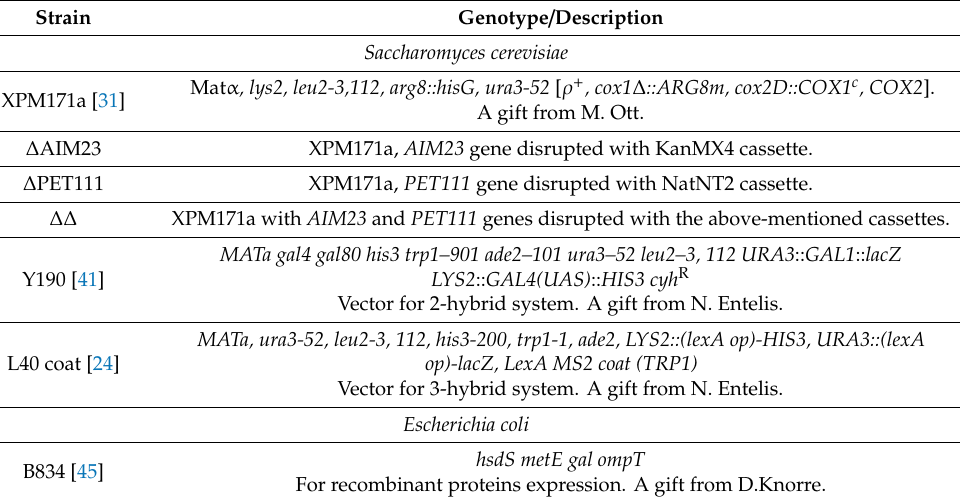
Table 2. Strains used in this study.